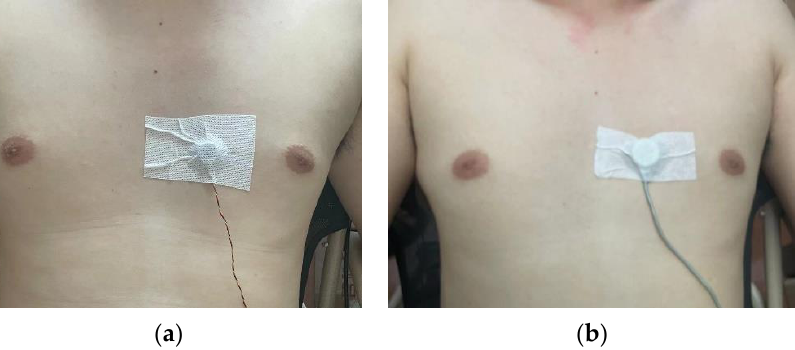
Figure 6. Sensors tested on the chest surface. ( a ) The novel heart sound sensor; ( b ) the sensor from ADInstruments.